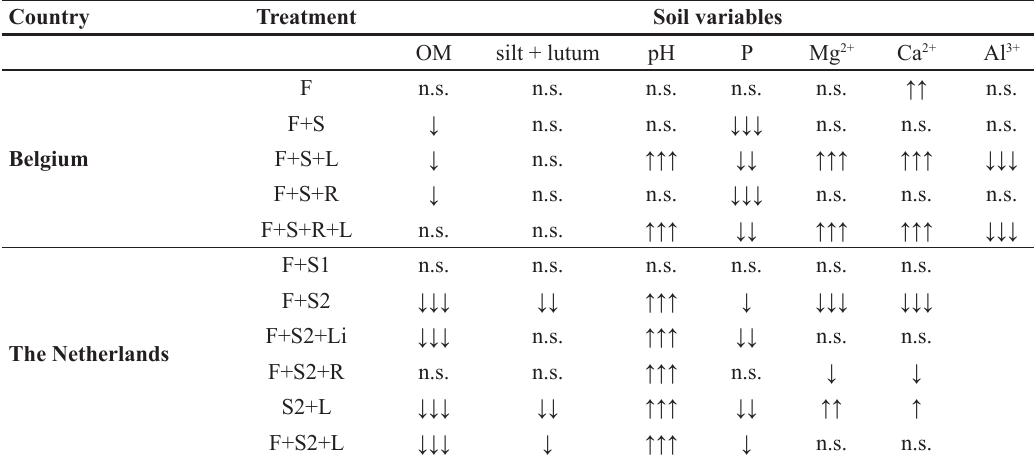
Table 2 – Soil variables in the different treatments compared to the control. The direction of the arrows indicates a higher (↑) or lower (↓) value in the treatment than in the control. The number of arrows reflect the significance of the statistical test. The total number of plots was n = 48 in Belgium and n = 56 in the Netherlands. n.s.: not significant, ↓ or ↑: p < 0.05, ↓↓ or ↑↑: p < 0.01, ↓↓↓ or ↑↑↑: p < 0.001. F: fencing; S: deep sod cutting in Belgium; S1: shallow sod cutting in the Netherlands; S2: deep sod cutting in the Netherlands; L: liming; R: rotavation; Li: addition of common juniper litter; OM: soil organic matter. All variables were log-transformed prior to the analyses except soil pH in the Country Treatment Soil variables OM silt + lutum pH P Mg 2+